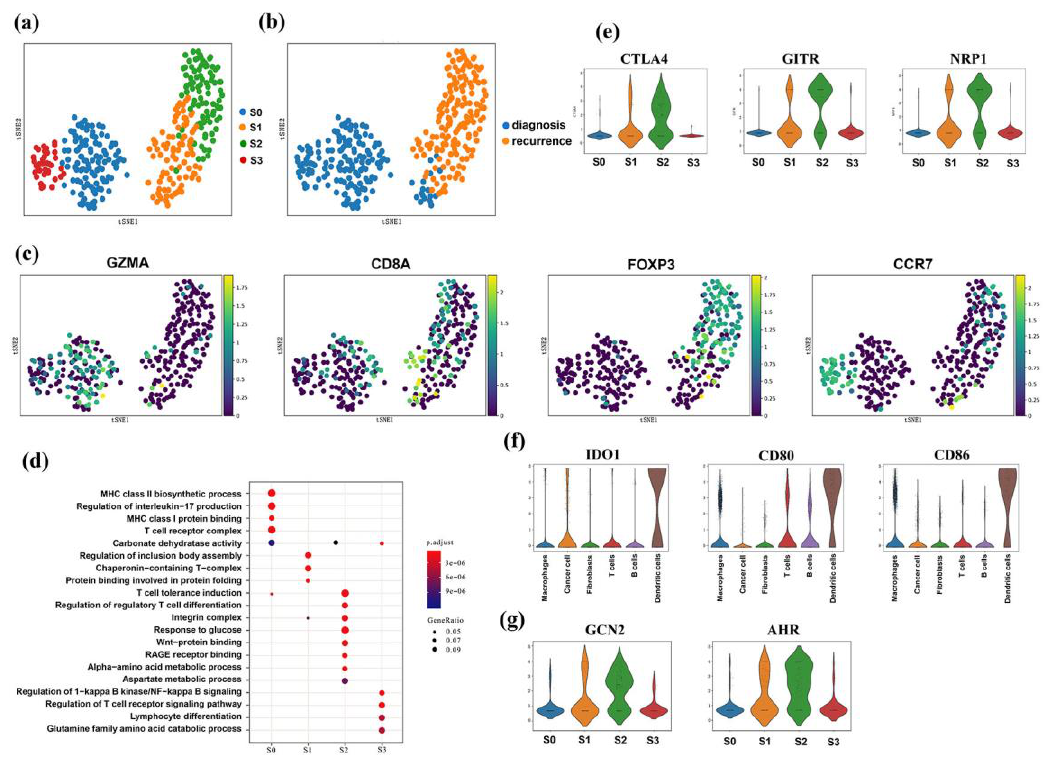
Figure 6. ScRNA-seq revealed heterogeneity in T immune cells. ( a,b ) T-SNE map of subcluster analysis for T immune cells, colored by cell types ( a ) and sample groups ( b ). ( c ) T-SNE maps show canonical markers for four T immune cell subtypes: GZMA for CD8 + T effector cells; CD8A for CD8 + T naïve cells; CCR7 for CD4 + T conventional cells; FOXP3 for CD4 + CD25 + T regulatory cells. ( d ) Functional analysis of differentially expressed genes among four subtypes of T cells. ( e ) Expression levels of other representative marker genes for CD4 + CD25 + T regulatory cells. ( f ) Dendritic cells highly expressed the IDO-related genes. ( g ) Tryptophan metabolism pathway-related genes were highly expressed in Treg cells.